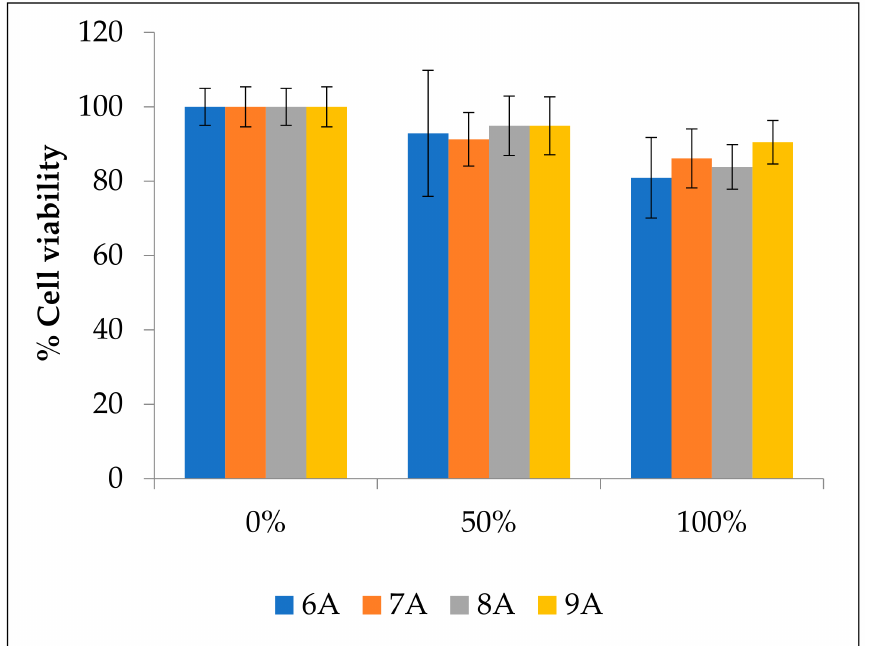
Figure 8. Cell viability values for scaffolds sintered at 600 (6A), 700 (7A), 800 (8A), and 900 ◦ C (900A) at different extract concentrations: 0% (0% extract, 100% DMEM medium), 50% (50% extract, 50% DMEM medium), 100% (100% extract, 0% DMEM